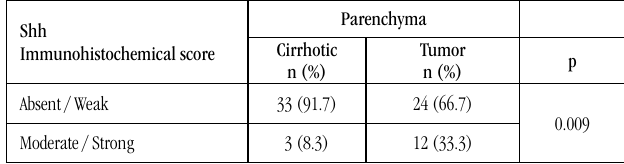
TABLE 2 - Morphological analysis of 36 cases of HCC from liver transplantation performed at HC-UFMG in the period between 2003 and 2015 Morphological analysis of HCC n (%) Number of Nodes